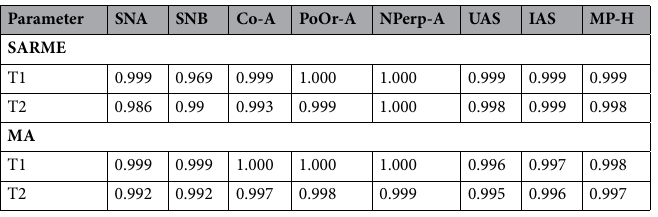
Table 3. Intraclass correlation coefficient (ICC). T1: preoperative; T2: postoperative.